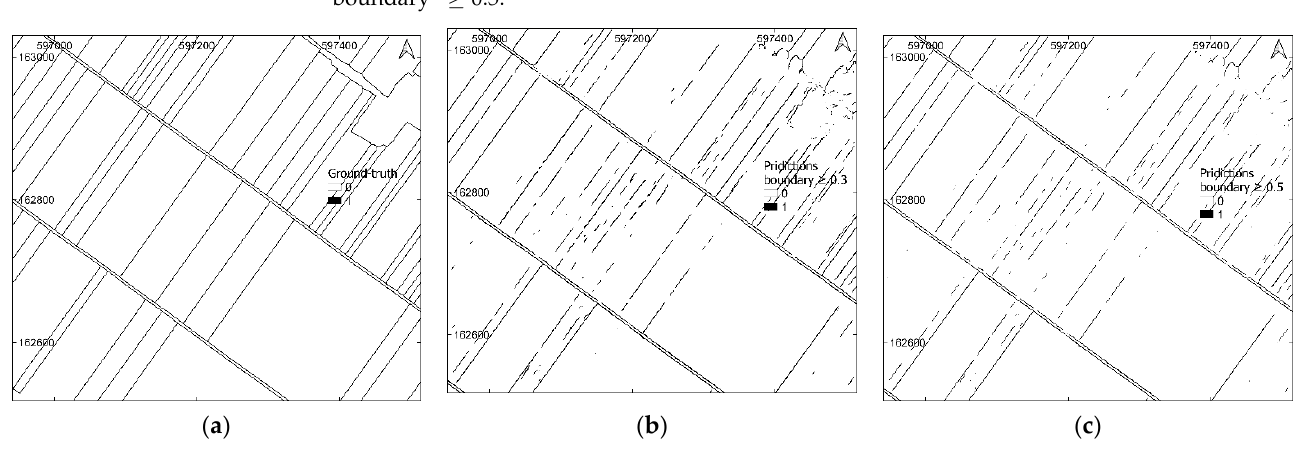
Figure 8. ( a ) Ground truth image for Odranci, Slovenia. ( b , c ) Reclassified boundary maps obtained with customised CNN: ( b ) with threshold 0.3, and ( c ) with threshold 0.5.